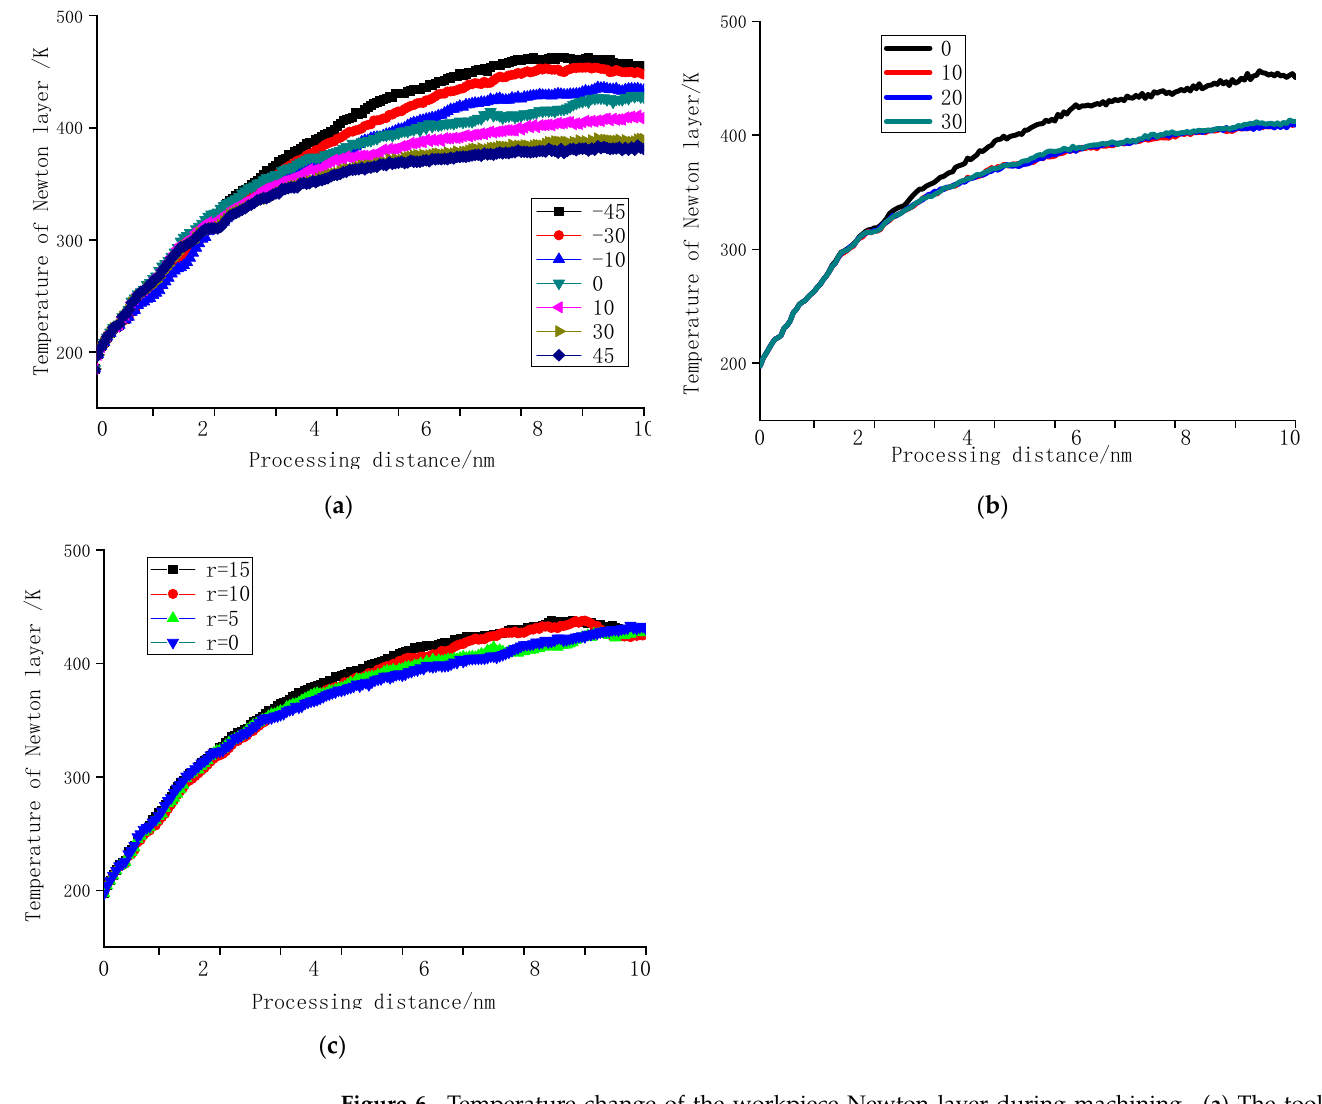
Figure 6. Temperature change of the workpiece Newton layer during machining. ( a ) The tool clearance angle α 0 = 10 ◦ and the edge radius r = 0.5 nm, when the tool rake angle is different. ( b ) The tool rake angle γ 0 = 10 ◦ and the edge radius r = 0.5 nm, and the tool clearance angle is different. ( c ) The front and clearance angles of the tool are the same, while α 0 = 10 ◦ and γ 0 = 10 ◦ , the edge radius is different.